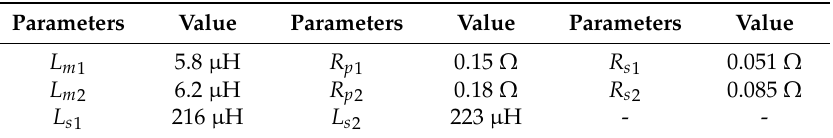
Table 3. Different system